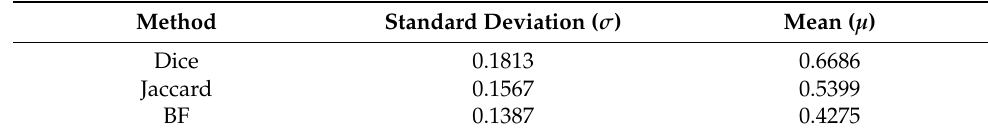
Table 1. Parameters of the Gaussian